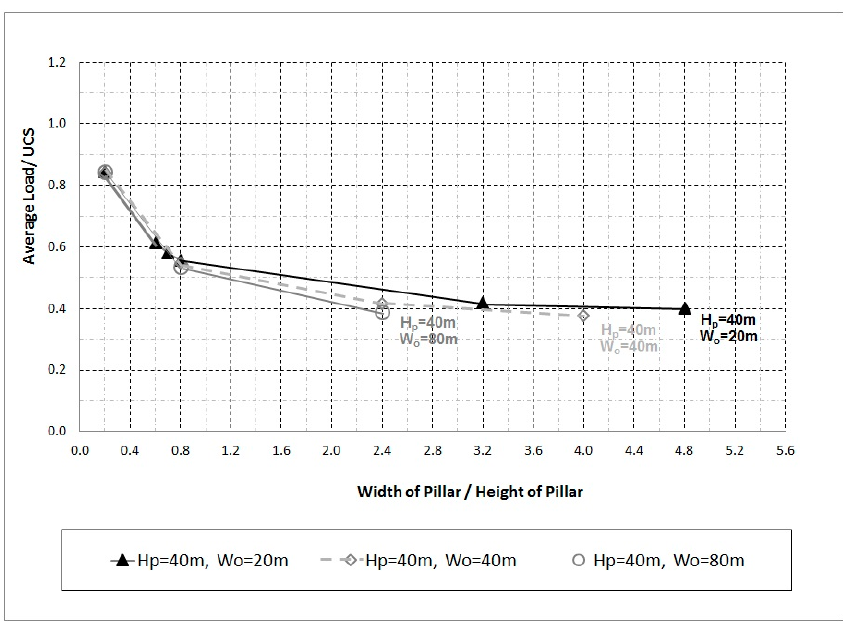
Figure 12. Modeling results—failure envelopes for different widths of opening W o .